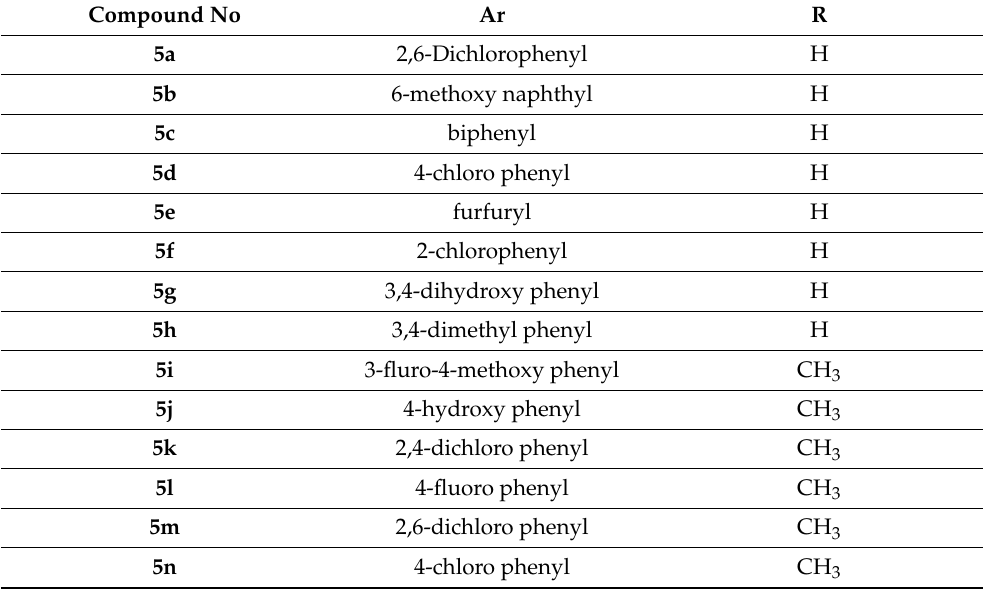
Table 1. Structural data of compounds 5a–n